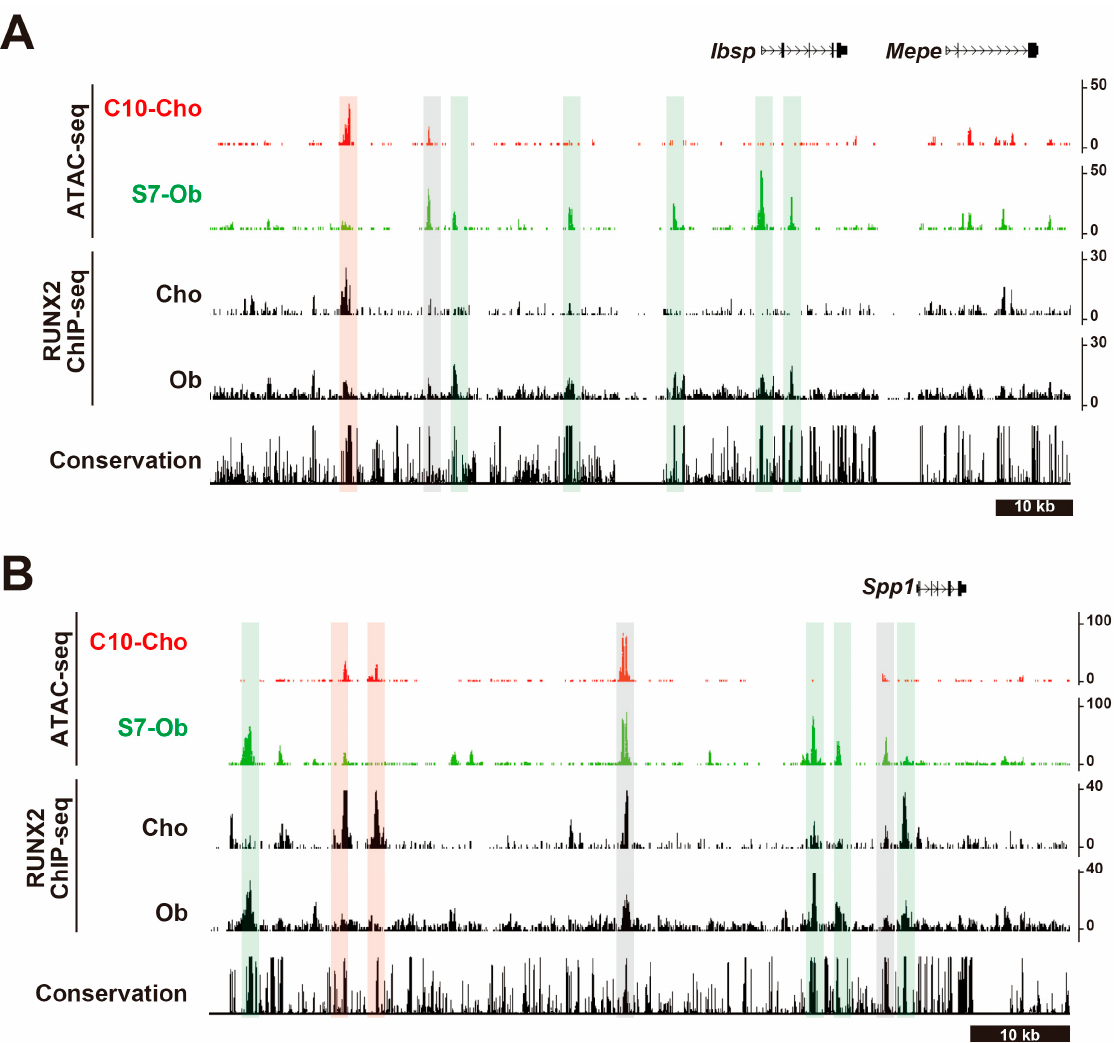
Figure 3. Chromatin accessibilities and RUNX2–DNA binding profiles in the flanking regions of Ibsp and Spp1. CisGenome browser screenshot showing chromatin accessibility and RUNX2–DNA binding profiles in the flanking regions of Ibsp ( A ) and Spp1 ( B ). C10-Cho: ATAC-seq data in sorted cells from Col10 mCherry positive chondrocytes isolated from neonatal rib cartilage in Col10 mCherry reporter mice, S7-Ob: ATAC-seq data in sorted cells from Sp7 EGFP positive osteoblasts isolated from neonatal calvaria bone in Sp7 EGFP mice. Genomic regions highlighted by green color are osteoblast RUNX2 specific regions, those in red are chondrocyte RUNX2 specific regions; those in gray are shared regions in RUNX2 osteoblasts and chondrocytes. These images were visualized by using GEO: GSE178293.